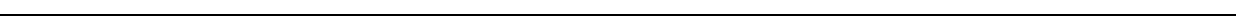
Fig. 1 G α i is required for the carvedilol-induced β 1 AR-mediated ERK phosphorylation both in vitro and in vivo. a Effect of PTX on carvedilol-induced β AR- mediated ERK phosphorylation in HEK293 cells. HEK293 cells stably expressing FLAG-tagged β 1 ARs or β 2 ARs were pretreated with vehicle or 200 ng per ml PTX for 16 h, then stimulated with indicated concentration of carvedilol for 5 min. Carvedilol induced ERK phosphorylation in both β 1 AR or β 2 AR stable cells in dose-dependent manner. The response in β 1 AR stable cells was blocked by PTX, whereas that in β 2 AR stable cells was PTX insensitive. b Effect of G α i knockout on β AR-mediated ERK phosphorylation in HEK293 cells. The G α i expression in β 1 AR or β 2 AR stable cells was depleted with CRISPR – Cas9 gene editing. Compared with wild-type β 1 AR stable cells, the carvedilol-induced ERK phosphorylation in G α i knockout β 1 AR stable cells was diminished. In comparison, the response in β 2 AR stable cells was not affected. c Effect of PTX on carvedilol-stimulated ERK phosphorylation in Langendorff perfused hearts from β 2 AR knockout mice or β 1 AR knockout mice. Mice were pretreated with vehicle or 25 μ g per kg PTX through intraperitoneal injection. 48 h after injection, mice hearts were excised and perfused with vehicle or 10 μ M carvedilol for 10 min. PTX diminished the carvedilol-induced ERK phosphorylation in hearts from β 2 AR knockout mice, but not β 1 AR knockout mice. Data represent the mean ± SEM for n independent experiments ( a , b ) or n animals ( c ) as marked on the fi gure. Statistical signi fi cance vs. control was assessed using two-way ANOVA ( a , b ) or one-way ANOVA ( c ) with Bonferroni correction. NS no stimulation; Carv carvedilol; Iso isoproterenol; p-ERK phosphorylated ERK; t-ERK total ERK; WT wild type; KO